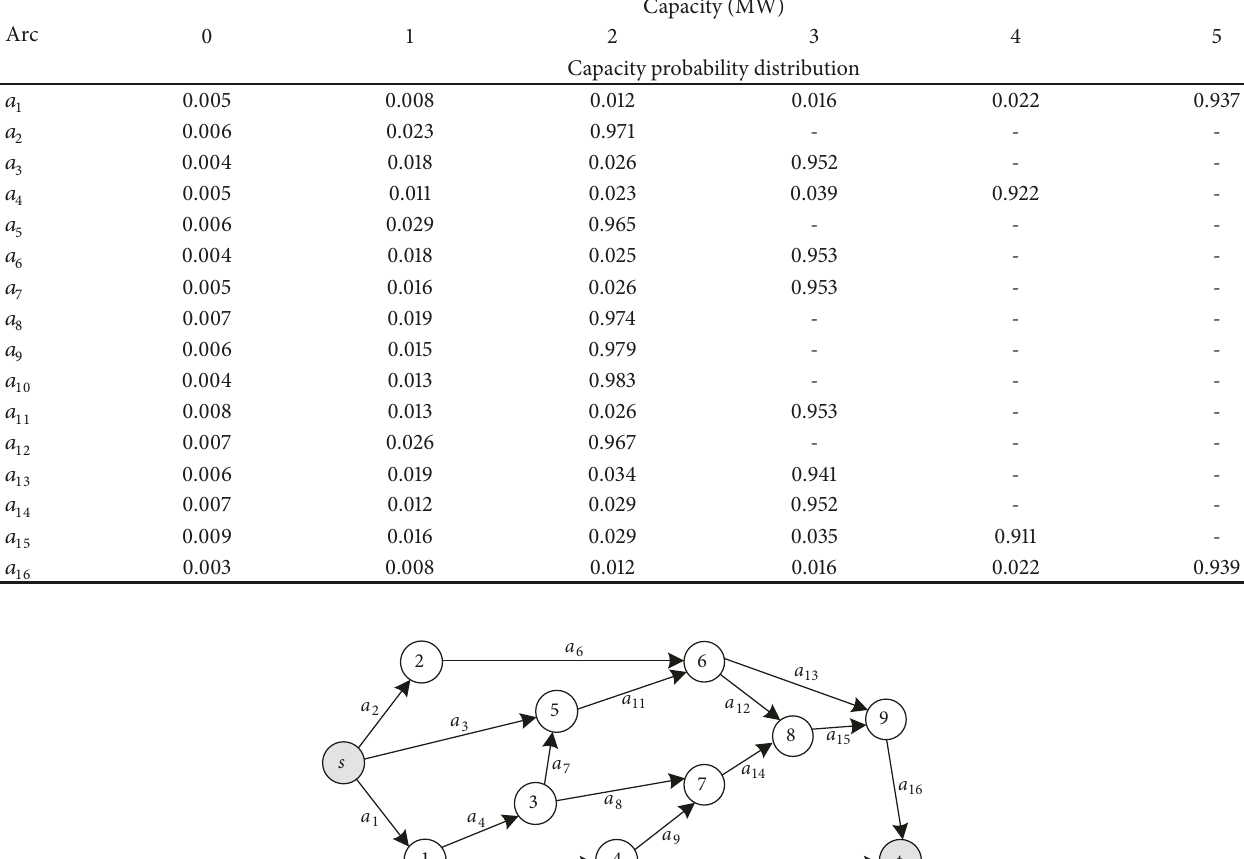
Table 3: Data of each arc (transmission line) of the power transmission network.